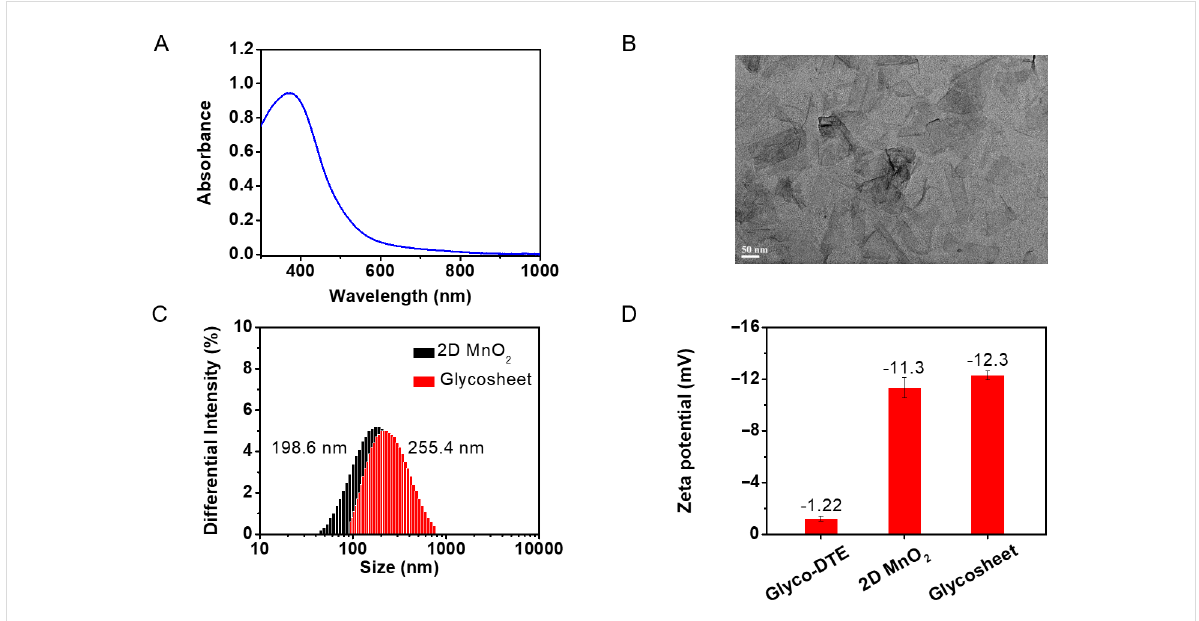
Figure 2: (A) The absorbance spectrum and (B) high resolution TEM image of 2D MnO 2 nanosheets (1 × 10 − 5 g/mL) in ultrapure water; (C) DLS and Zeta potential characterizations of 2D MnO 2 photochromic glycosheet.